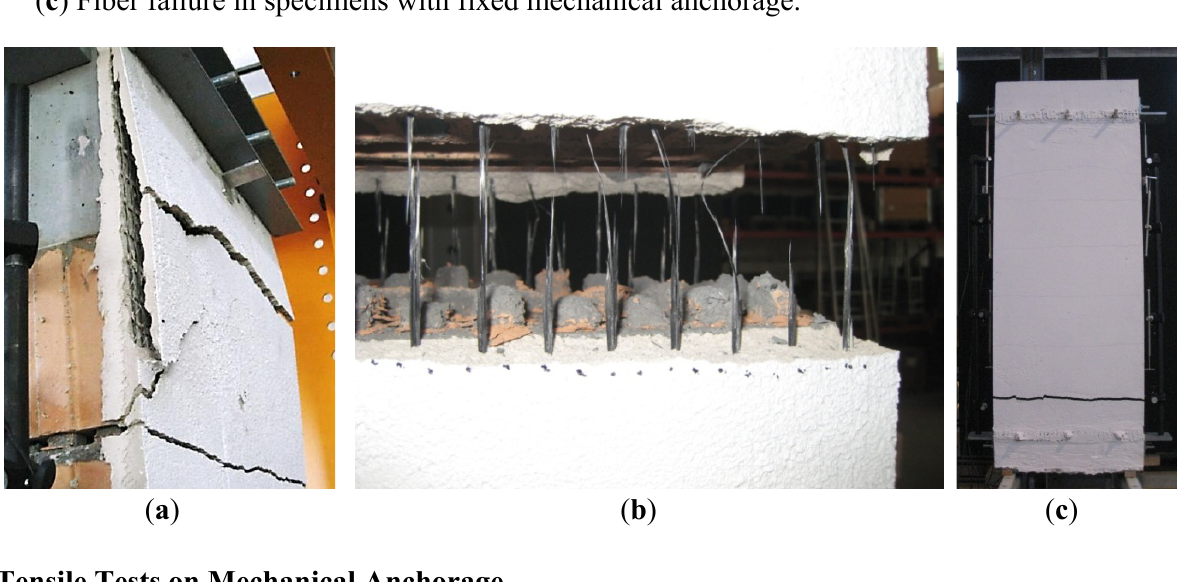
Figure 10. Test specimens after failure. ( a ) Pulled out fibers from mechanical anchorage in ( c ) Fiber failure in specimens with fixed mechanical anchorage.